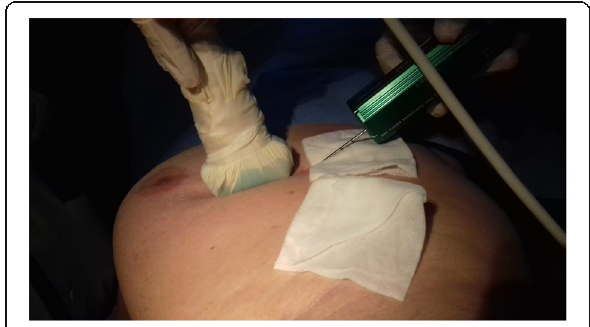
Fig. 1 Ultrasound-guided core needle biopsy. The patient is in supine position. After local anaesthesia, the ultrasound probe (on the left) guides the needle to the lesion